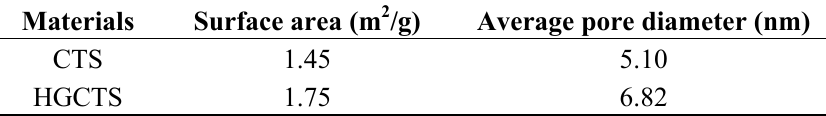
Table2. Physical properties of CTS and